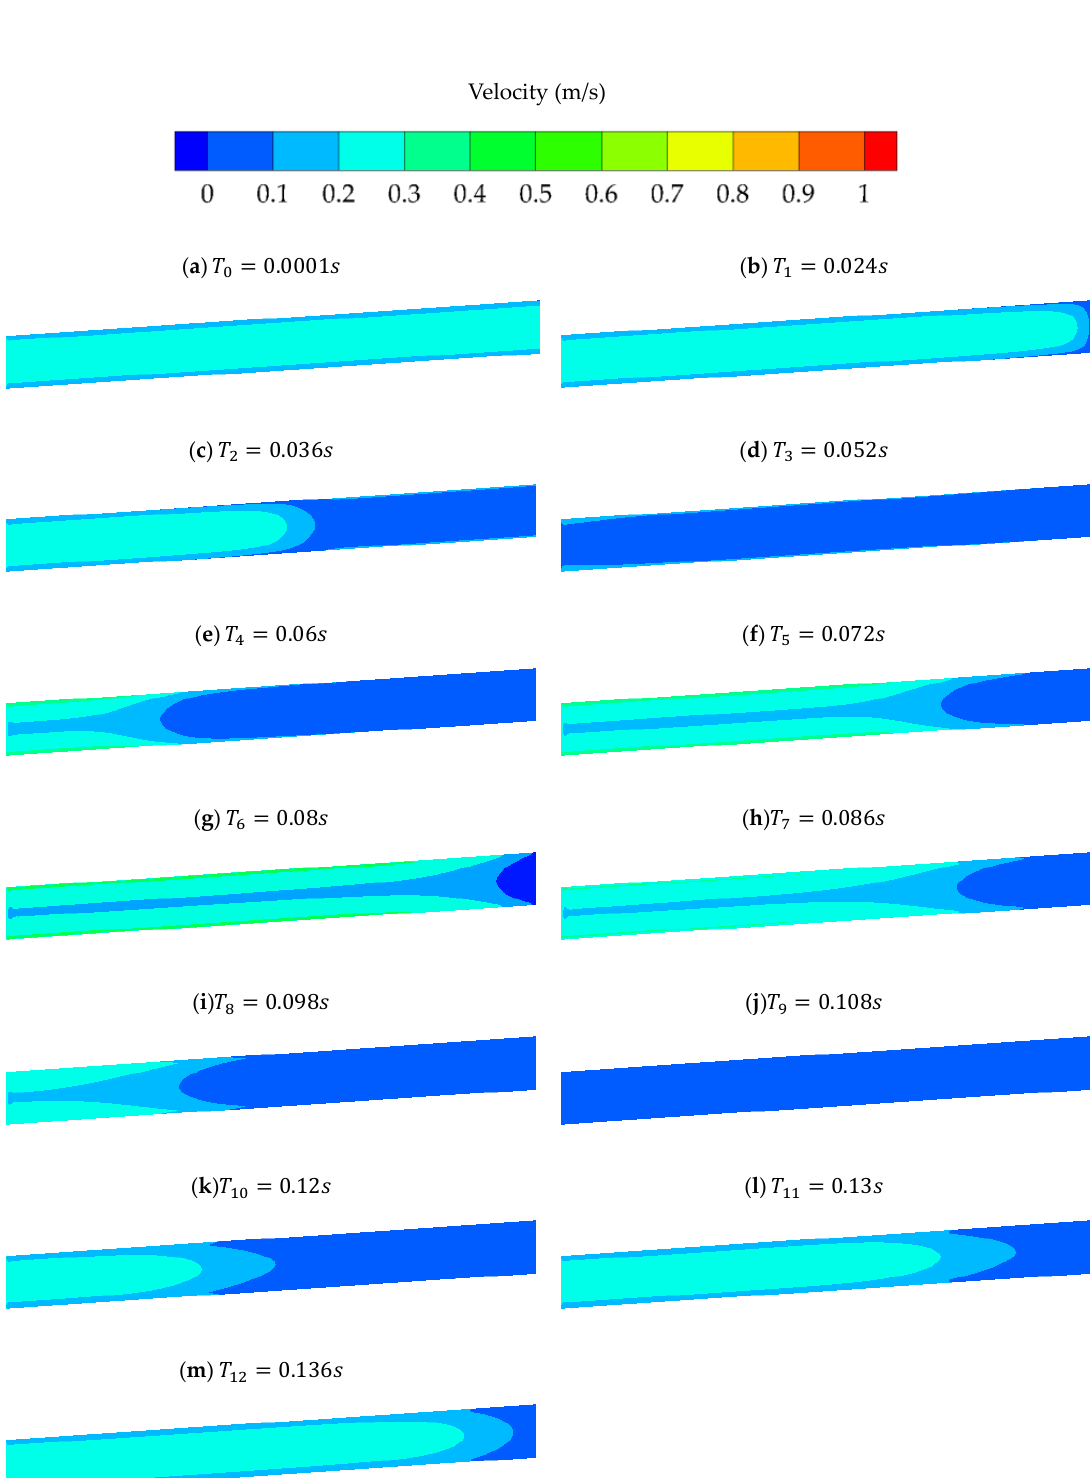
Figure 8. Velocity field evolution during the first wave cycle on the axis plane of the pipeline.